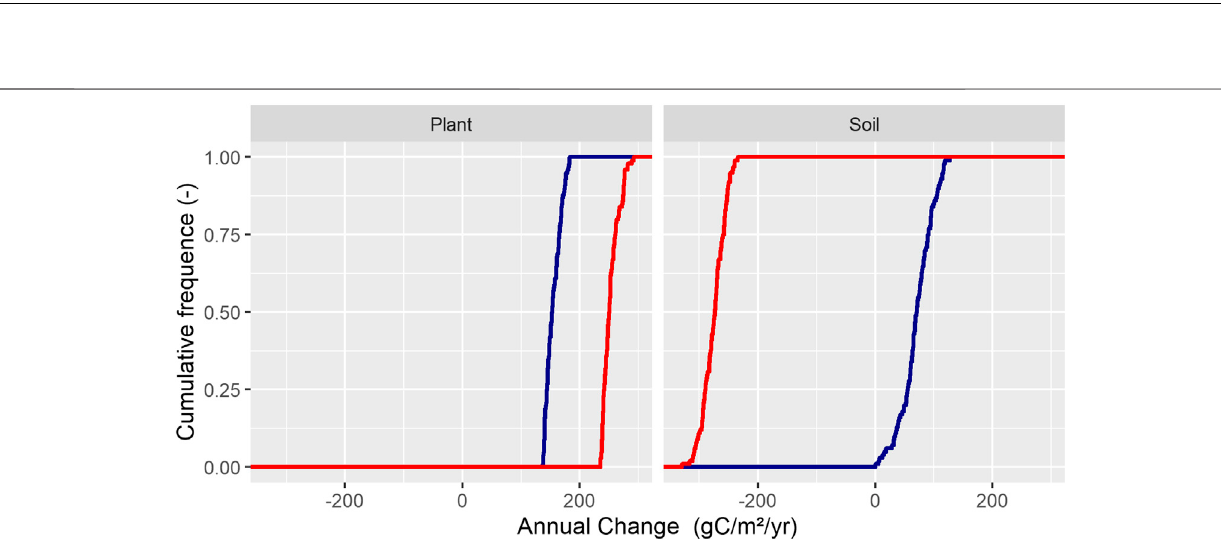
Frontiers in Environmental Science |